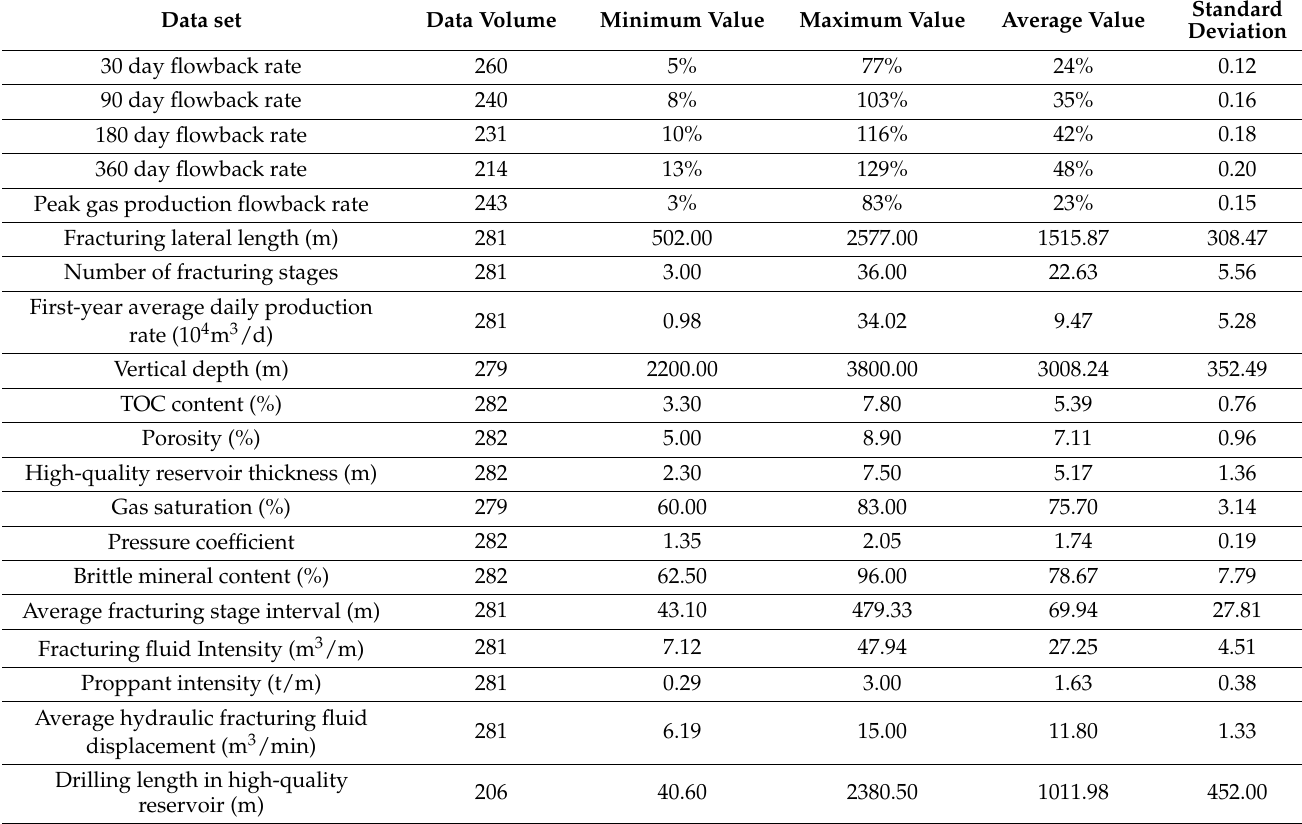
Table 1. Statistical tables of data for the study area. Copyright permission: The copyright of Table 1 belongs to the publisher and